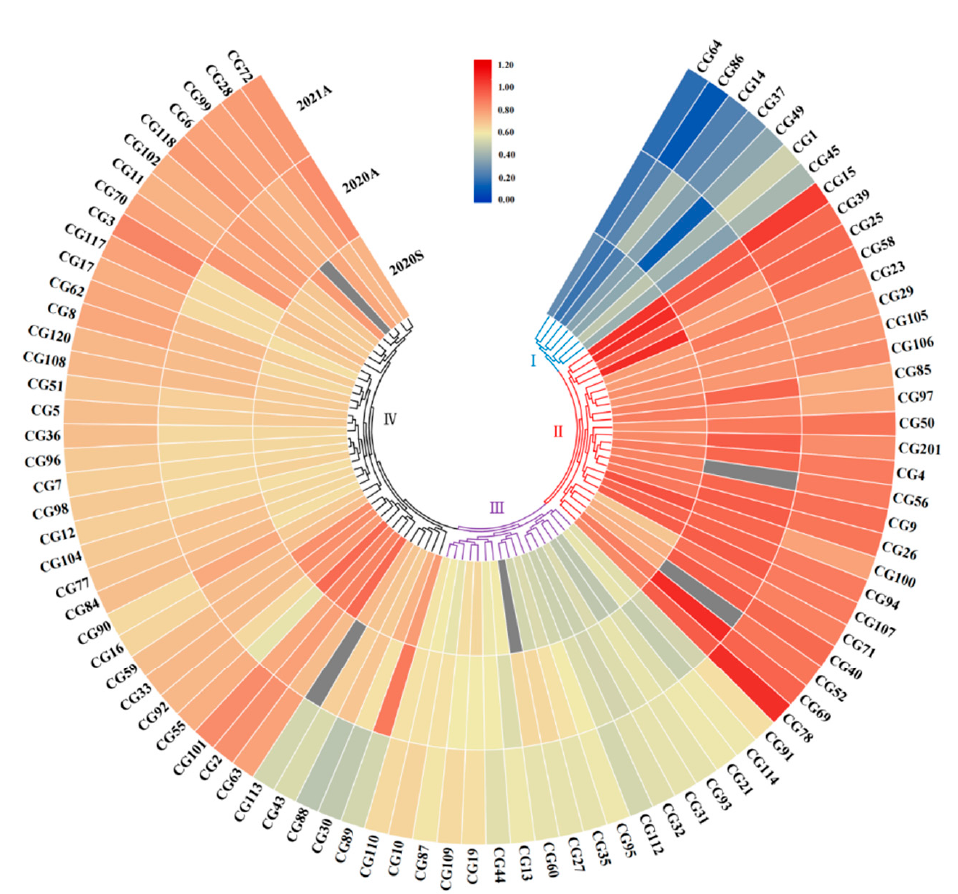
Figure 2. Heatmap depicting the phenotypic distribution of cucumber stem diameter in the three seasons. The four clusters of core germplasm (CG) lines are numbered with I to IV. Color intensity indicates stem thickness of the line. Gray means data were unavailable.